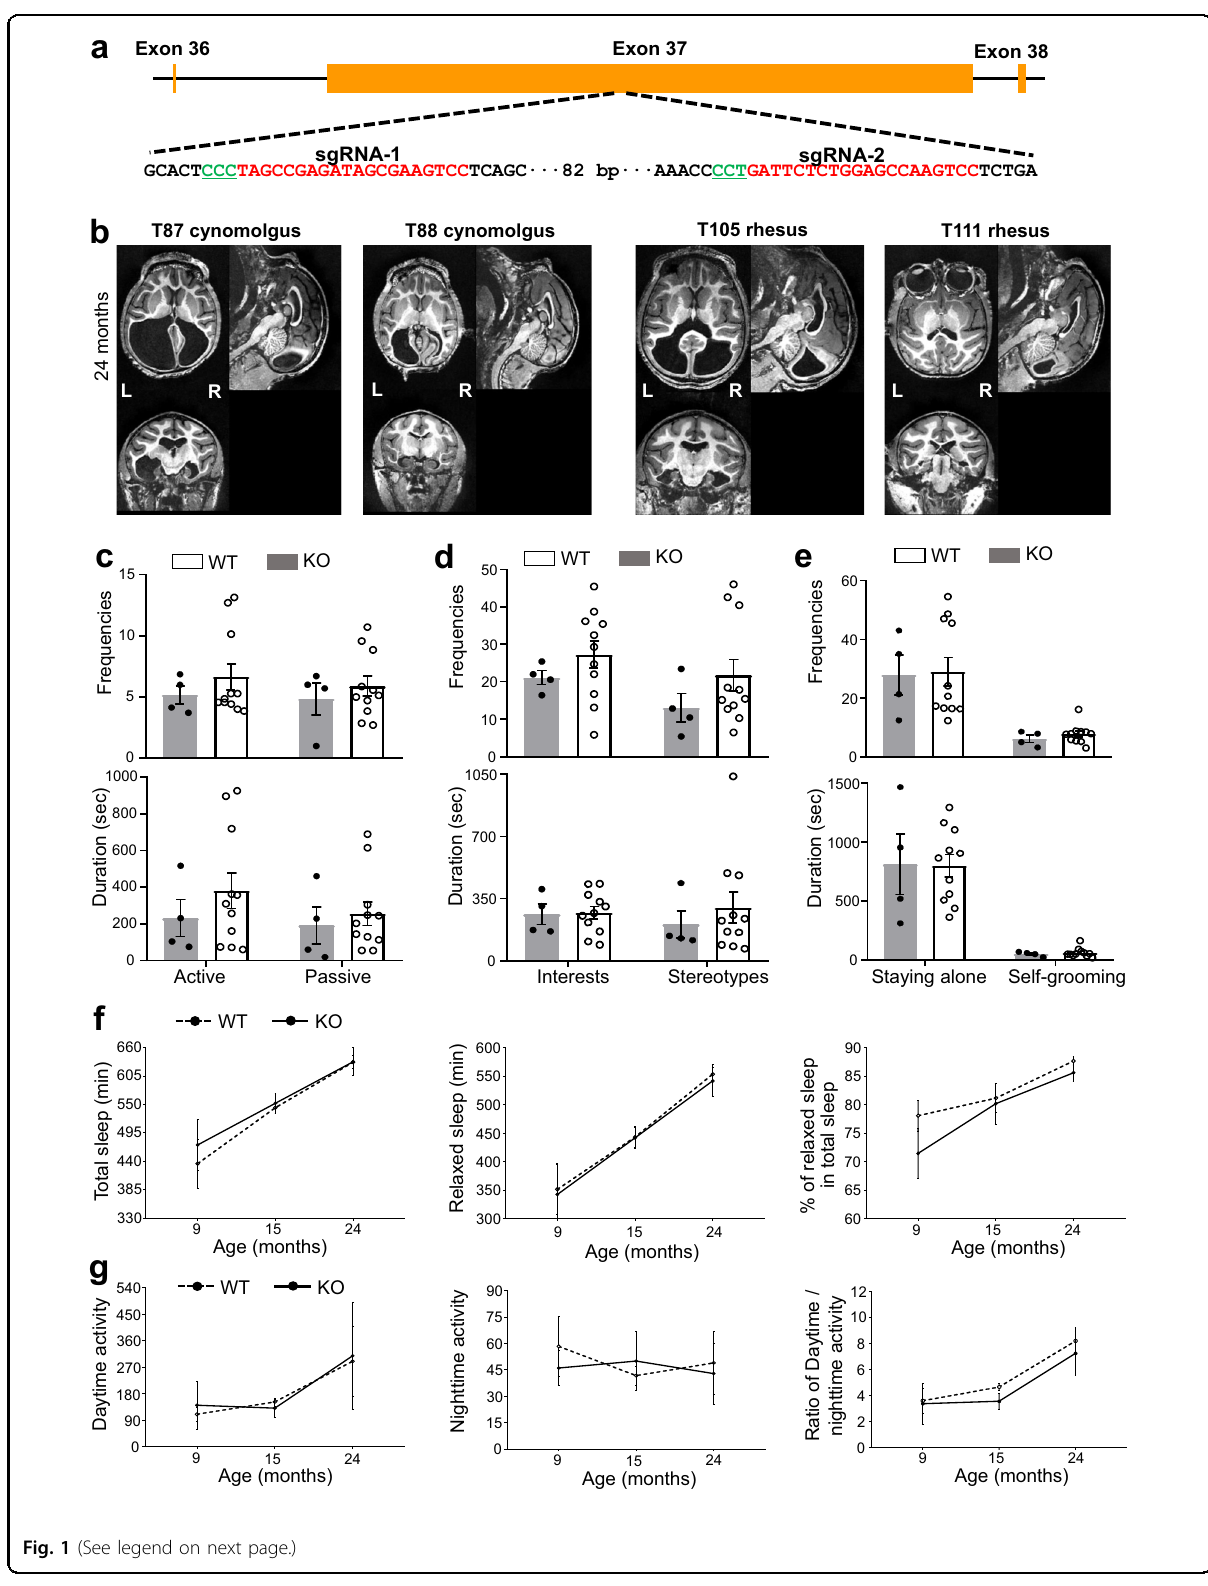
Fig. 1 (See legend on next